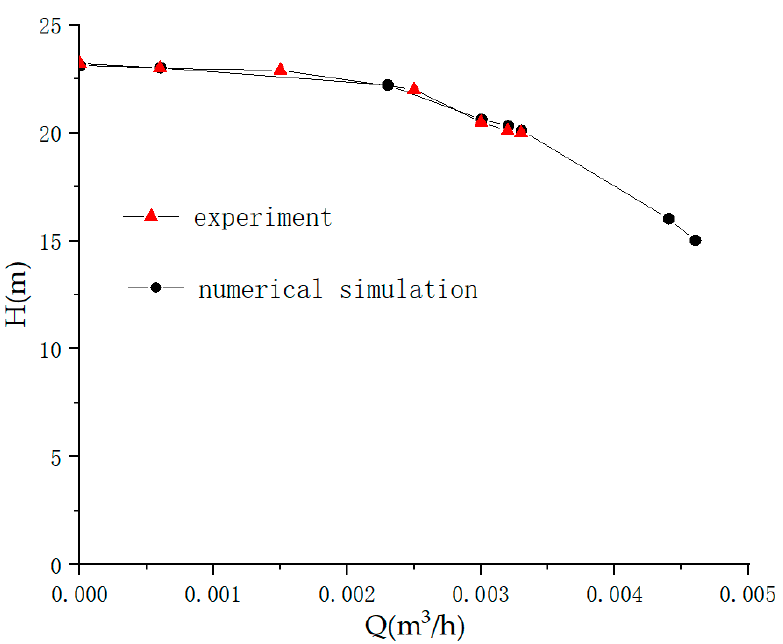
Figure 13. Comparison of the experimental and steady numerical simulation.